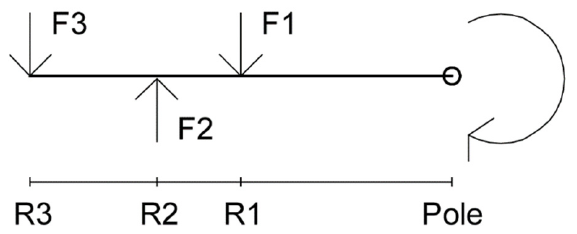
Figure A9. Representation of the masticatory system and the device neglecting internal forces. Since the upper and lower forces are not applied along the same axis, the resultant unbalanced moment would generate a rotation. The direction of this moment will depend on the difference R 1 − R 2. However, since the real device does not actually rotate during the task, other constraints would compensate for the resultant moment. Therefore, the contact points R 3 and R 4 can be reconsidered as applied points for constraint forces, which balance that moment. Whether R 1 < R 2, the moment would have a clockwise direction and negative sign, which will unload on R 3 (Figure A10).